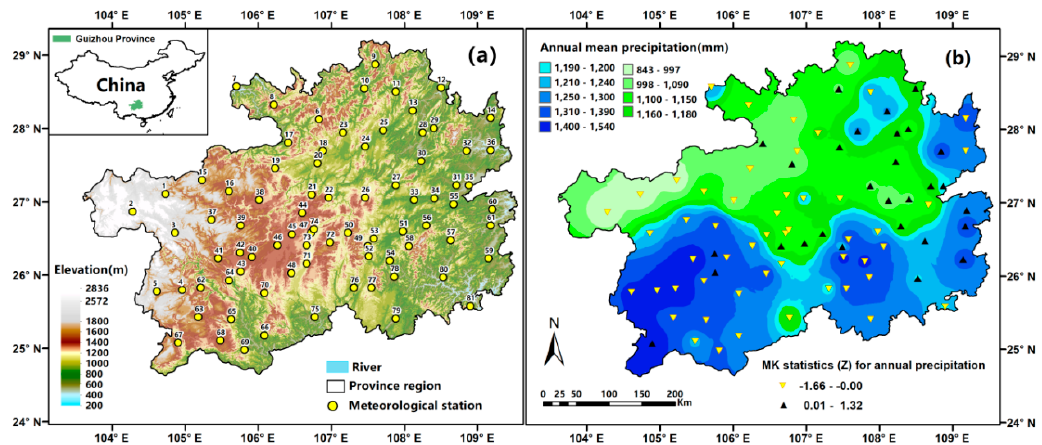
Figure 1. Spatial distribution of topography and meteorological stations ( a ), and mean annual precipitation and changes (increasing or decreasing trend) from 1961 to 2004, and ( b ) in the study region, yellow triangle denotes insignificantly decreasing trend and black triangle denotes a insignificantly increasing trend at the 0.05 level .